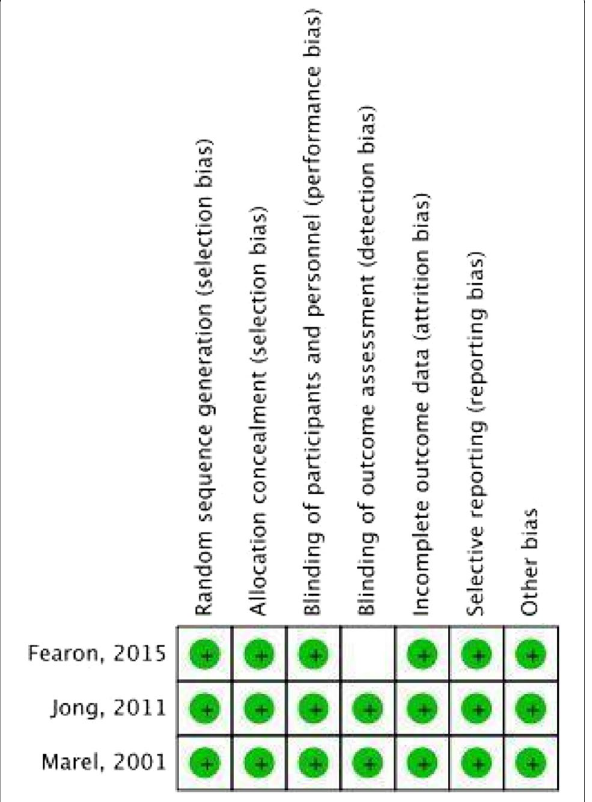
Fig. 4 Risk of bias assessment summary for the randomized controlled trials